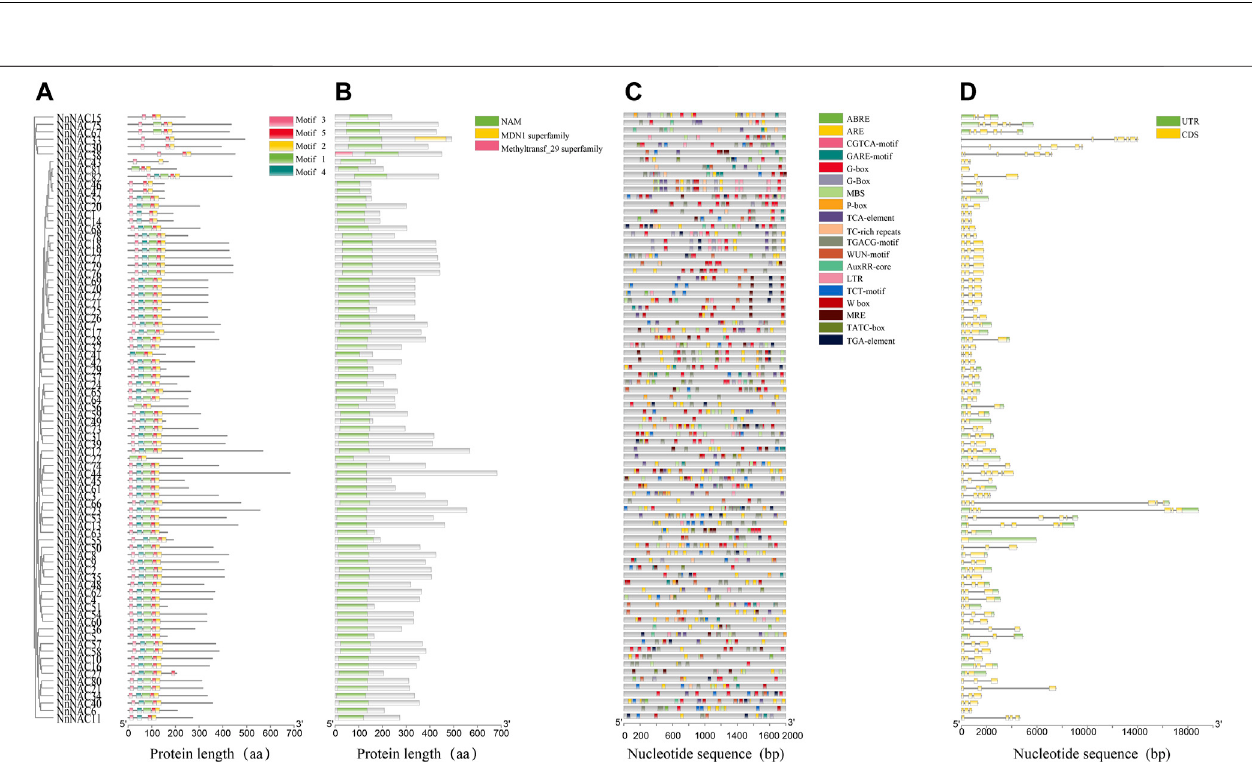
FIGURE 2 | Conserved motifs, cis -elements and NnNAC gene structure analyses. (A) Clusters and conserved motifs of NnNAC proteins. (B) Screening of conservedNACdomaininlotus. (C) Identi fi cationof cis -regulatoryelementsinthe2-kbupstreampromoterregionsof NnNAC genes. (D) Thelotus NAC genestructures.